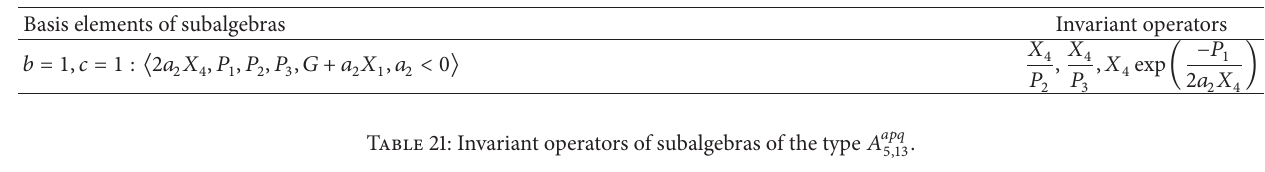
Table 20: Invariant operators of subalgebras of the type 𝐴 𝑏𝑐 5,9 .